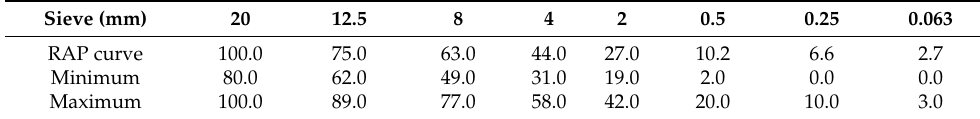
Table 1. Granulometric band RE2 (PG4). % Passing.